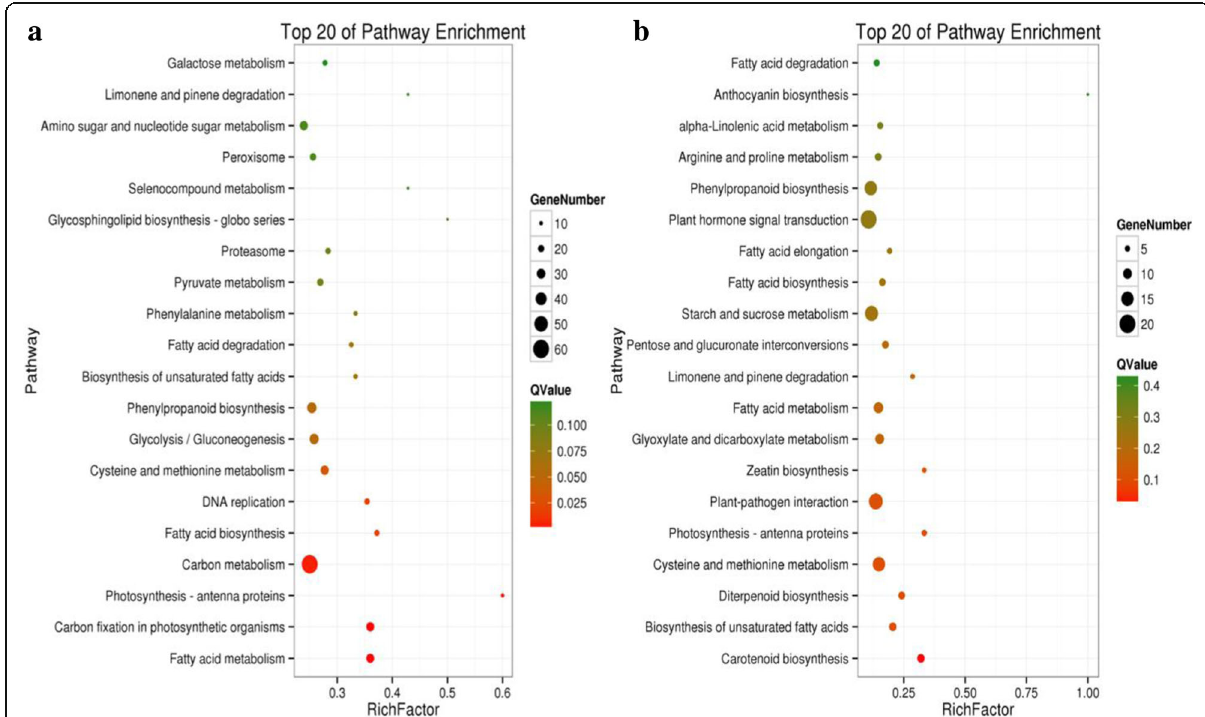
Fig. 7 KEGG pathway assignments of DGHP. a KEGG analysis of DGHP between CHT025 and WFYT025. b KEGG analysis of DGHP between WFB and WFYT025. Both ( a ) and ( b ) showed the top 20 most represented categories and the number of transcripts predicted to belong to each